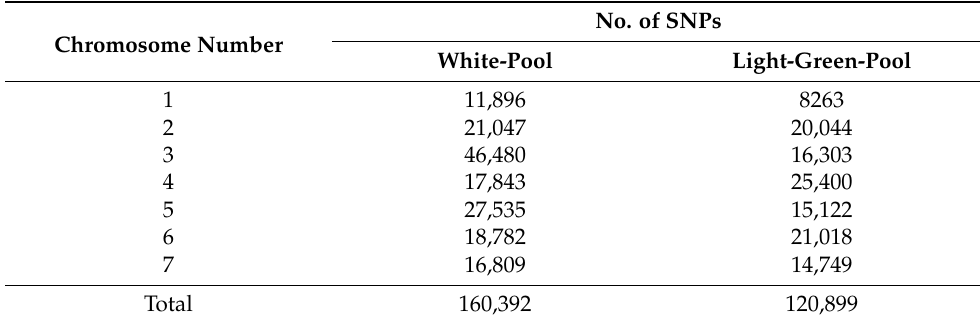
Table 3. Polymorphisms identified in QTL-seq